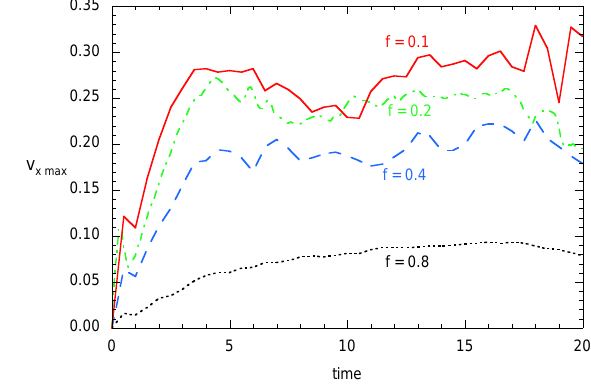
Fig. 10. Properties of a depleted flux tube that also includes an initial density reduction but unchanged temperature, for y m = 0 . 2 and t = 20, showing (from top to bottom) 1B z = B z − B z,bg , where B z,bg is the background field outside the bubble, the temperature, and the change of density 1ρ = ρ − ρ bg and pressure 1p = p − p bg , again subtracting the background fields outside the bubble. The solid lines are magnetic field lines bounding the depleted flux tube. They are identified by tracing the motion of the equatorial crossing points of the initial depleted flux tube.